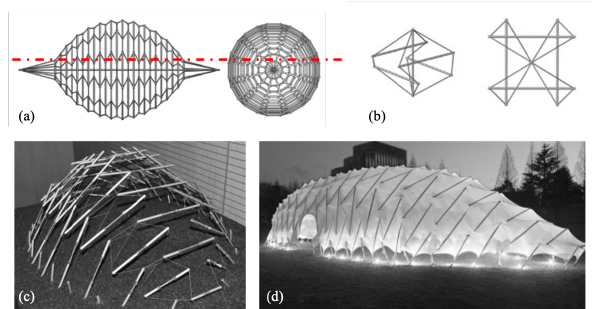
Figure 10: The tensegrity balloon in (a) can be obtained as a gener- alization of the seed structure in (b); (c) A section of the system in (a) can be isolated and anchored to the ground [10]; 80 × 60 × 40cm model realized by Davide Cadoni; (d) MOOM installation realized by Kazuhiro Kojima and C+A in 2011 [11].